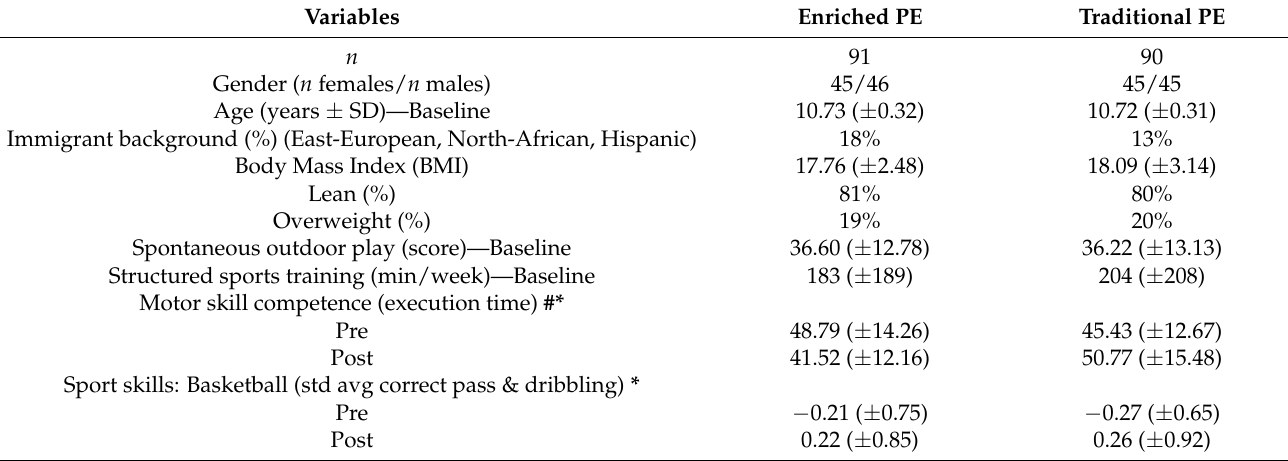
Table 1. Demographics, baseline levels of spontaneous outdoor play and structured sports training, and baseline (t1) and post-intervention (t2) values of motor skill competence, sport skills (basketball and soccer), cool executive functions (inhibition, working memory), hot executive functions (decision making in ball game), self-rated and peer-rated prosocial behavior (cooperation, empathy) and antisocial behavior (quick-temperedness/disruptiveness) of 10–11 year-old children assigned to the multisport enriched physical education (PE) intervention or traditional PE.